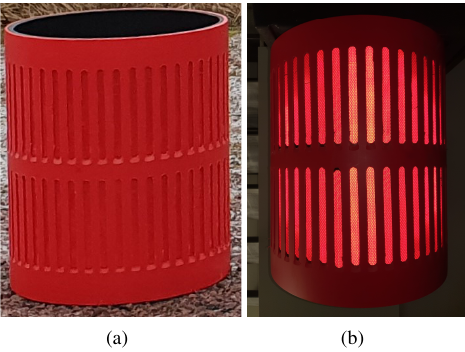
Figure 4: Pictures of a cut-down segment of a navigation aid in natural lighting (a), and with an illumination source placed in front of the NAVAID cylinder to illustrate the retroreflective strips (b). The NAVAID is cylindrical and has a highly retro-reflective ma- terial embedded in recesses around the surface (illuminated in Figure 4b).